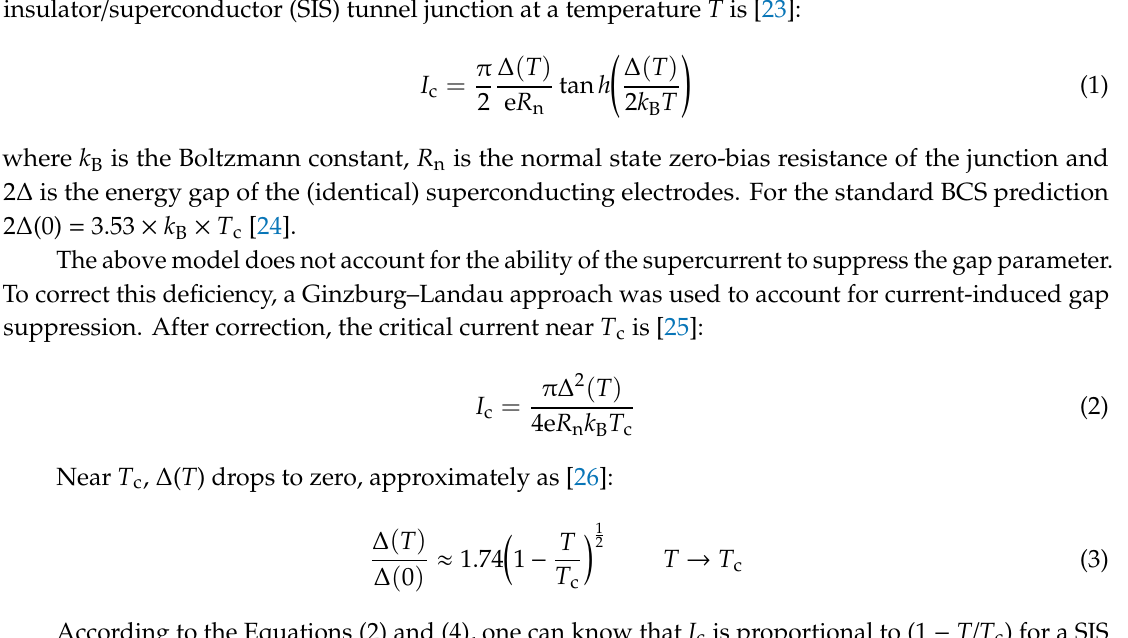
/ LAO (40 nm) / YBCO trilayer with the test c for the YBCO